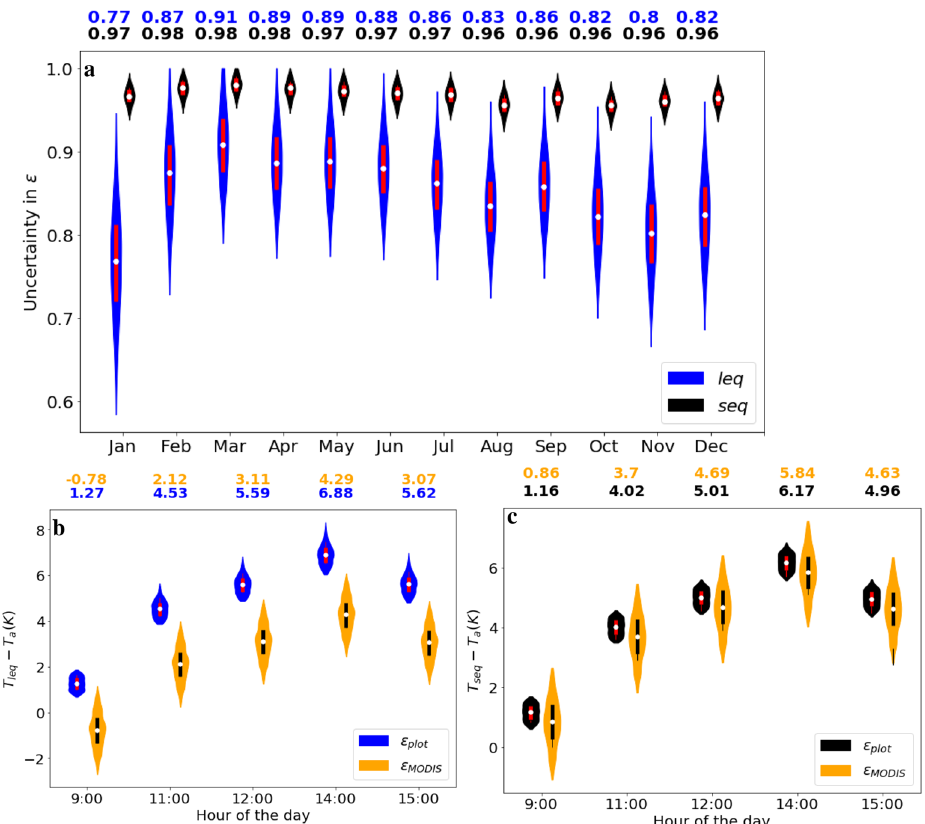
Figure 6. Uncertainty in plot-scale estimations of ε and surface-air temperature differences ( T s − T a ) at Alice Springs (AS), based on Eq. (7) (no intercept in H (� T ) ). Monthly values of ε shown for 2017 and hourly T s − T a for 15 August 2017. ( a ) Uncertainty in monthly ε plot due to uncertainty in H , R lup , R ldw and T a , using Eq. (5) (‘leq’, blue) and Eq. (9) (‘seq’, black). ( b ) Hourly uncertainty in T s − T a on 15 July based on Eq. (5), due to uncertainty in R lup , R ldw and T a when landscape-scale emissivity is used ( ε MODIS , orange) or due to uncertainty in H , R lup , R ldw and T a when ε plot is used (blue). ( c ) Same as Panel b, but based on Eq. (9). The white dots represent the median values of each distribution, the bars extend between the 25 and 75% quantiles and the outer-most violin represent the full distributions of the